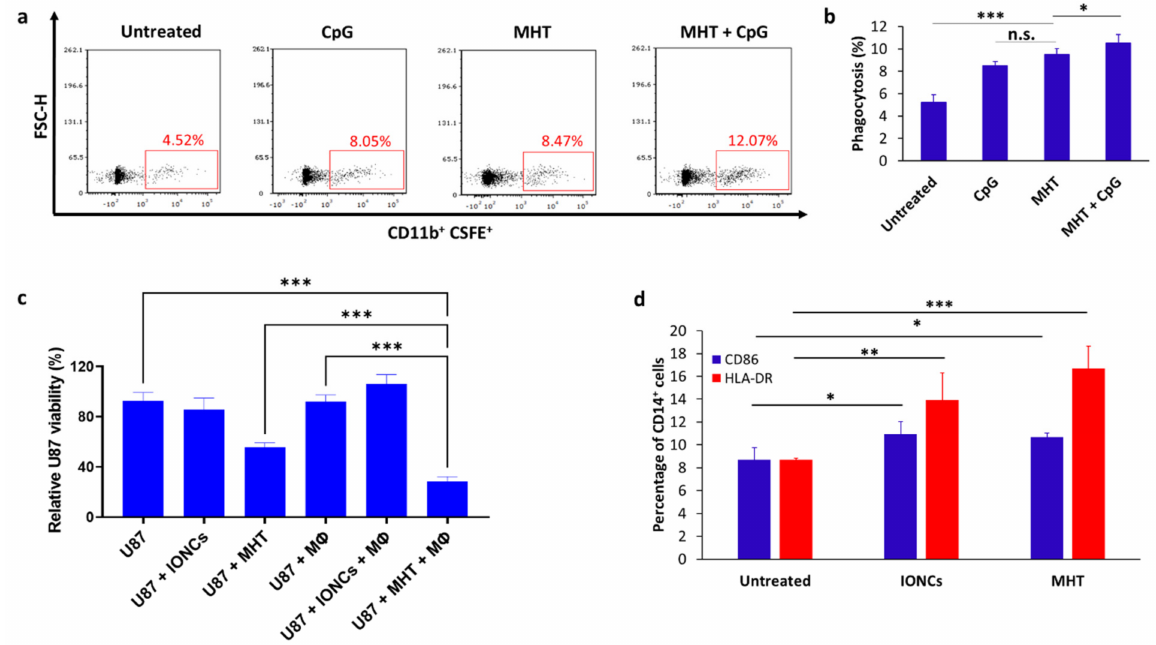
Figure 5. Representative dot plots showing phagocytosis of MHT − treated U87 cells by THP − 1 − derived macrophages (M φ ) after 2 h of coculture at a 1:1 effector: target (E:T) ratio ( a ). Flow cytometric quantification of phagocytosis rates by THP − 1 − derived M φ towards untreated or MHT − treated U87 in the presence or absence of TLR9 agonist CpG ( b ). Percentage of phagocytosis was determined by the percentage of CSFE + cells within CD11b + M φ cell gate (double positive). Tumor cell killing by macrophages was evaluated via crystal violet staining after 24 h of co − culture with untreated or treated U87 cells with IONCs only (U87 + IONCs) or with IONCs and MHT (U87 + MHT) ( c ). Activation of THP − 1 − derived macrophages was evaluated via analysis of surface expression of CD86 (blue bars) and HLA − DR (red bars) after 48 of co − incubation with untreated U87 cells, U87 cells exposed to IONCs (IONCs) and MHT-treated U87 cells (MHT) ( d ). All data are shown as mean ± SD. Statistical analysis was conducted via two − tailed unpaired student’s t test (* 0.01 < p < 0.05; ** 0.001 < p < 0.01; *** p < 0.001; n.s. = not